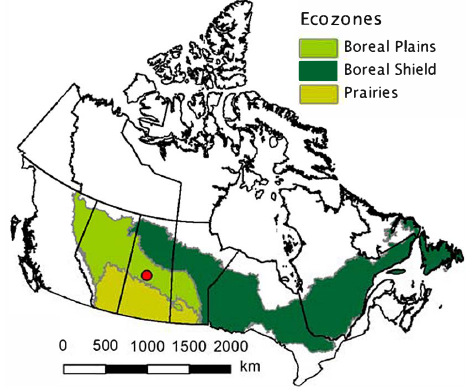
Figure 1. The location of the study site (Old Aspen flux